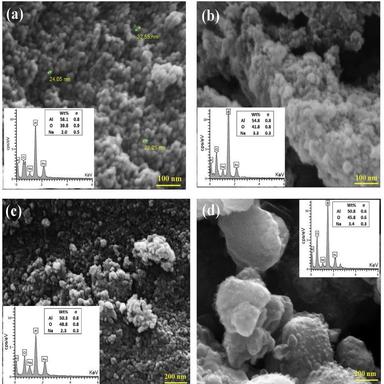
FESEM images and corresponding EDX analyses of the as-synthesized (a) aluminum hydroxide aged for 1 h, (b) aluminum hydroxide aged for 48 h, (c) alumina obtained after calcination of 1-h aged aluminum hydroxide, and (d) alumina obtained after calcination of 48-h aged aluminum hydroxide.